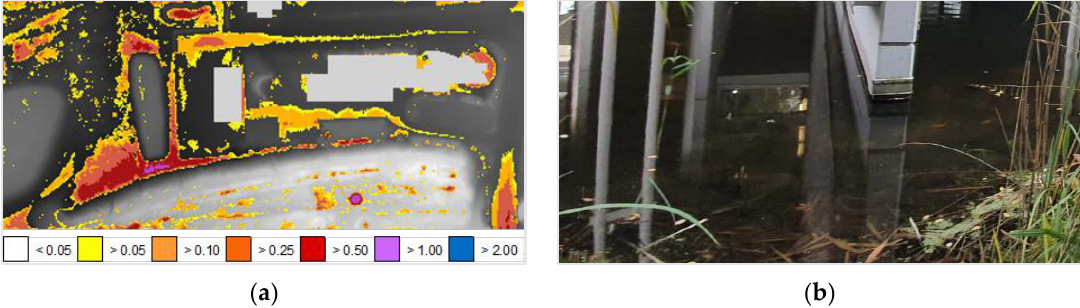
Figure 9. Predicted flood extent and depth after the precipitation: ( a ) flood map on the surface model which was used for the simulation; ( b ) existing water in the artificial pond.